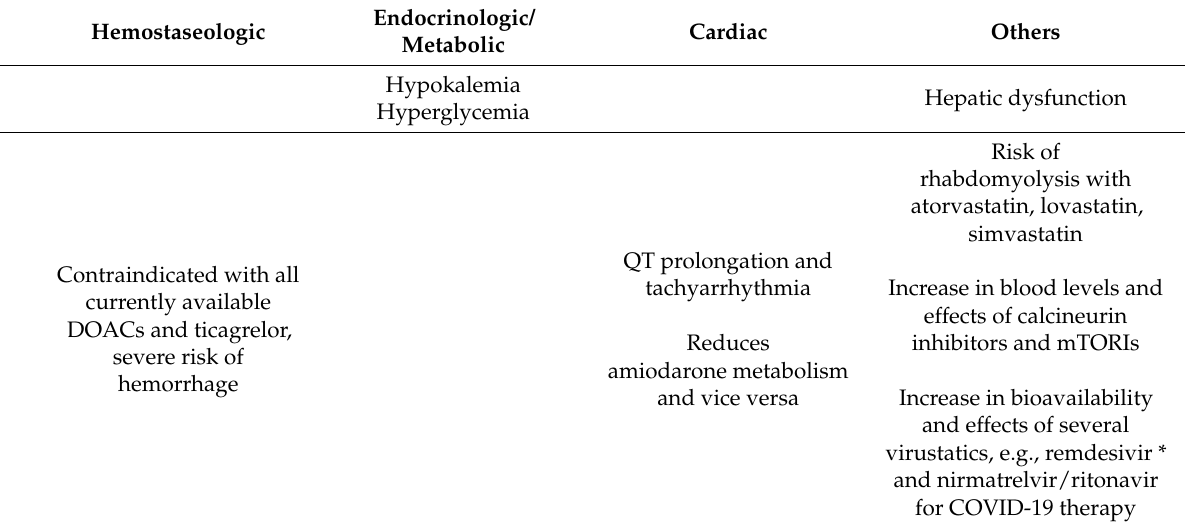
Table 1. Under-recognized potential ADRs and DDIs of clinical relevance from IPM insights with primary reference to their Summaries of Product Characteristics. This table is intentionally incomplete and excludes the more familiar gastrointestinal, nephrotoxic, several QT prolonging, several cutaneous dermatologic, and all anaphylactic and further